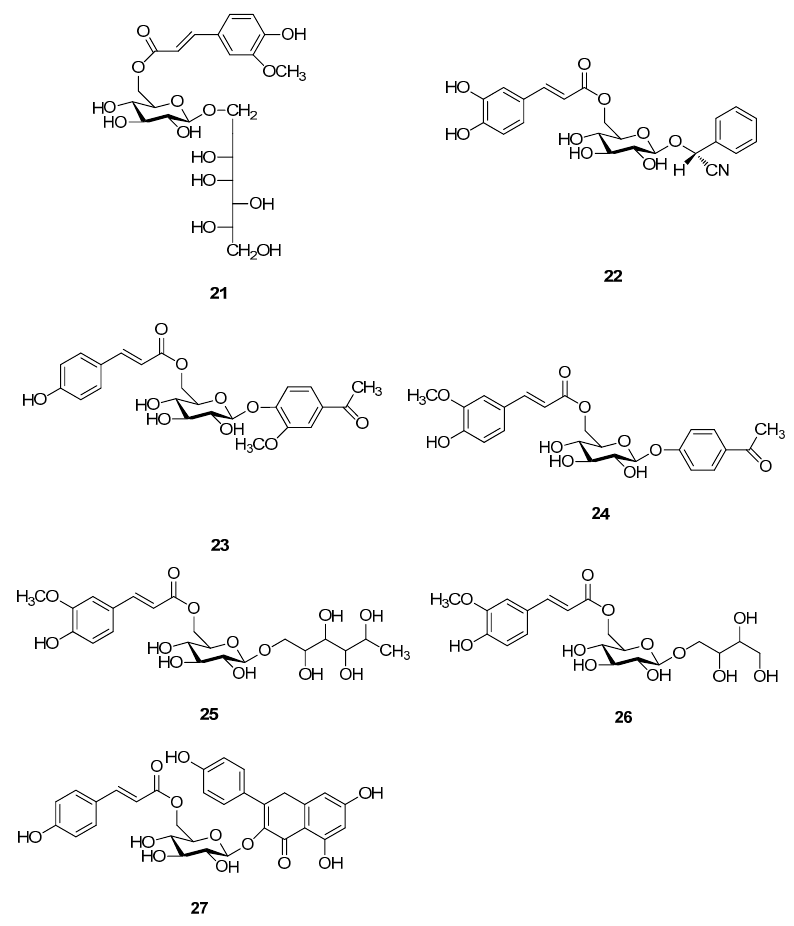
Figure 5. Structures of compounds 21 – 27 .